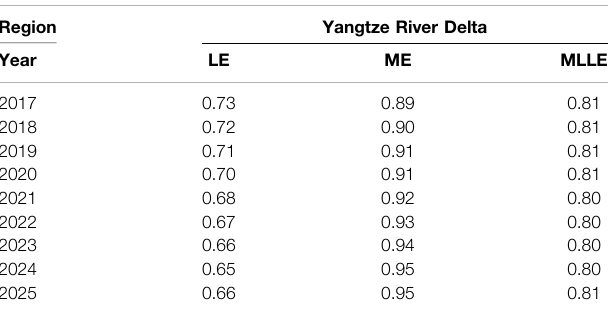
TABLE 10 | Development trend forecast of the ef fi ciency of the linkage development of the two industries in the Yangtze River Delta from 2017 to